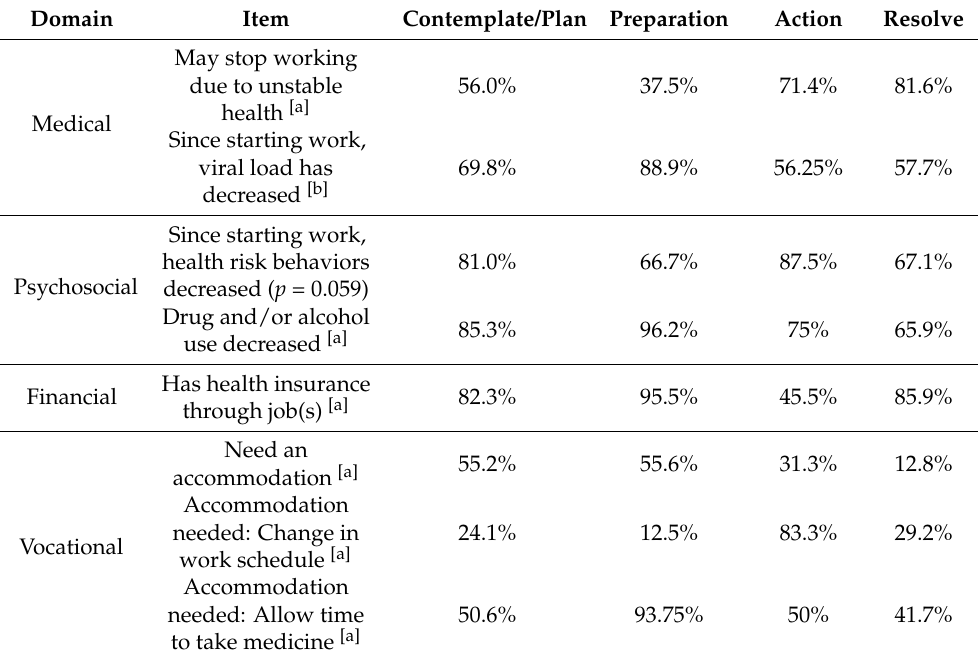
Table 5. Relationships between domains of influence and employment decision